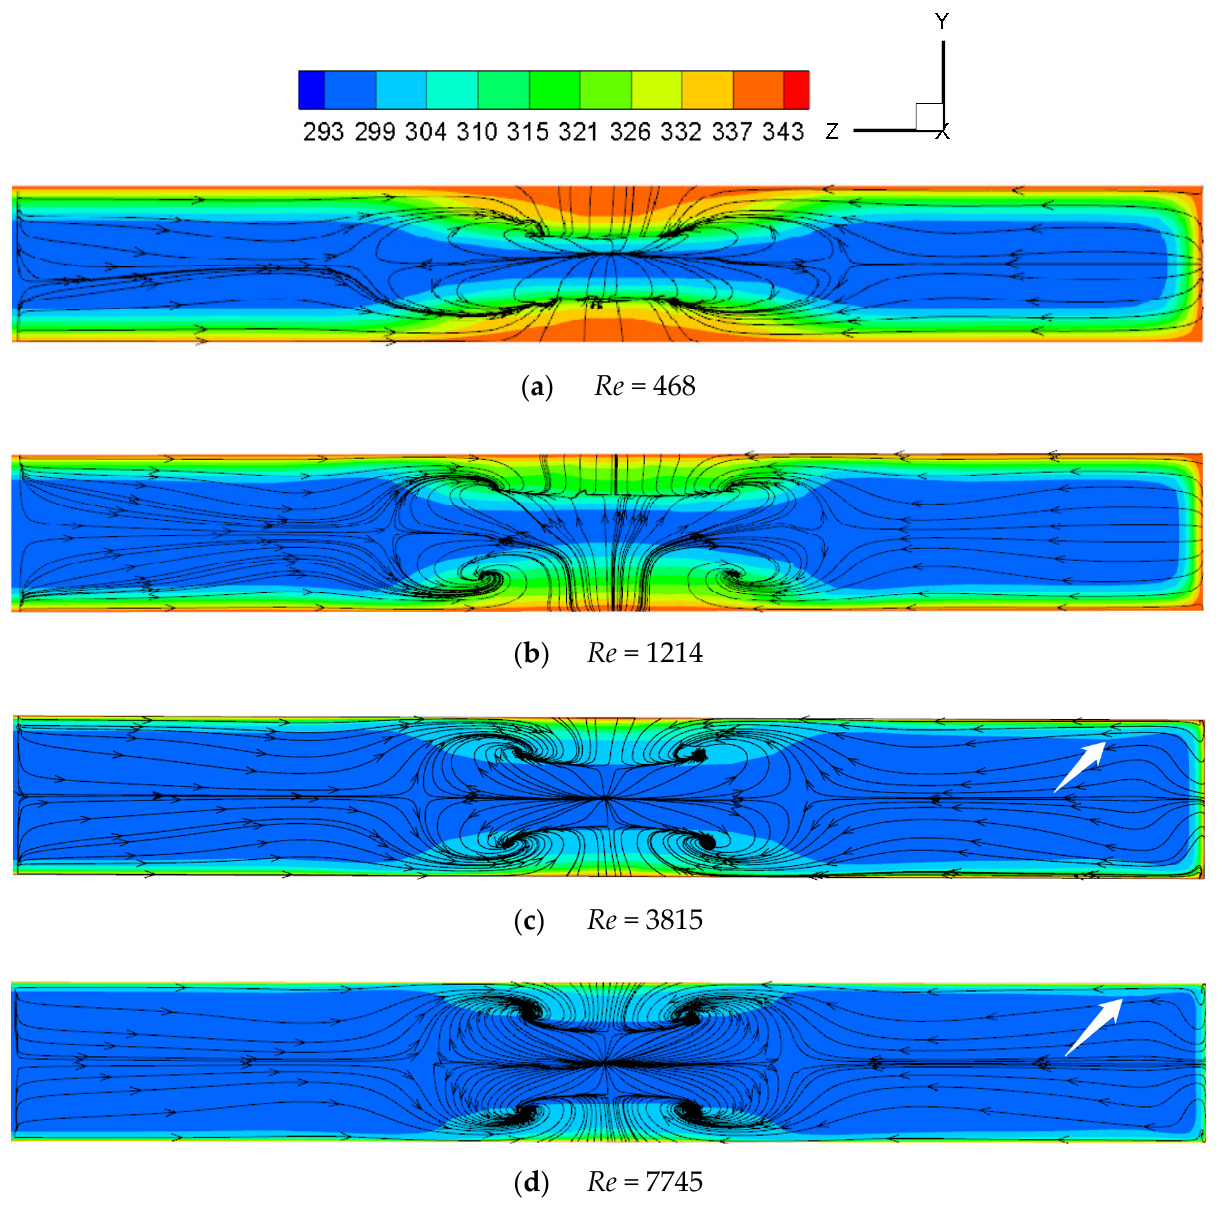
Figure 27. Temperature contours and streamlines on the tail section of protrusion (unit: K). Since the Nusselt number distribution on the primary wall around the downstream protrusions is almost the same as that of the second row, the Nusselt number contours on the primary wall around only the first and second rows of protrusions are shown in Figure 28. Because the distribution of the Nusselt number and the geometry are symmetrical in the Z direction, only half of them is